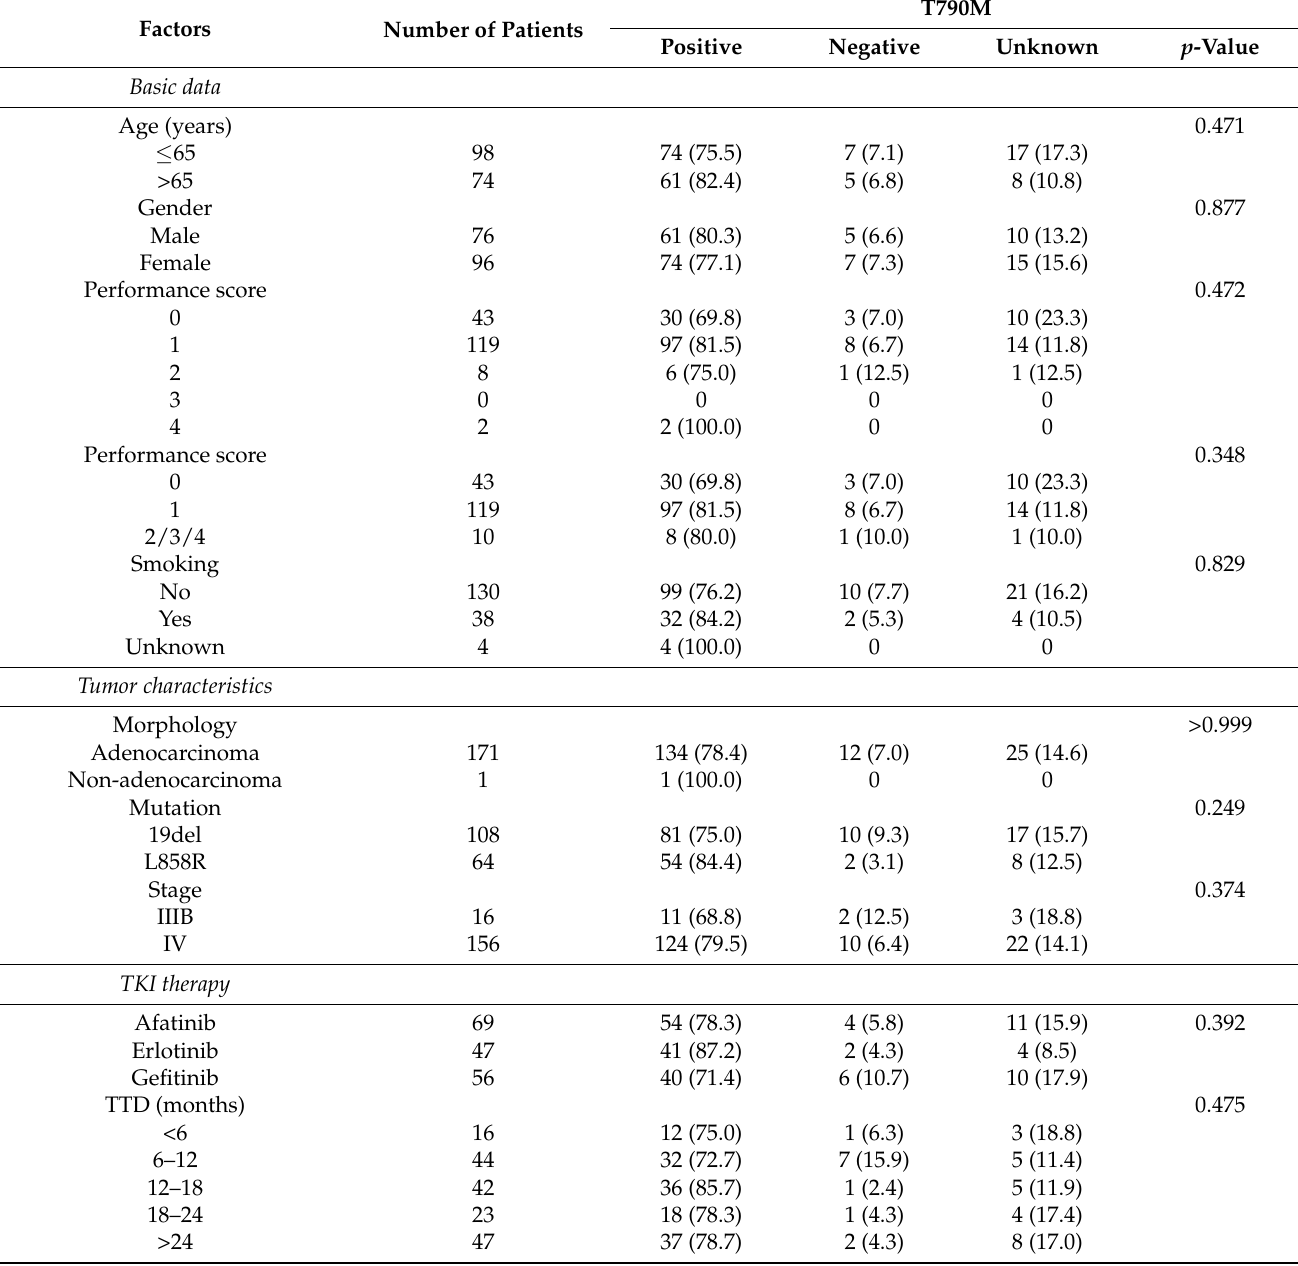
Table 1. Univariate and Multivariate analysis ( n =